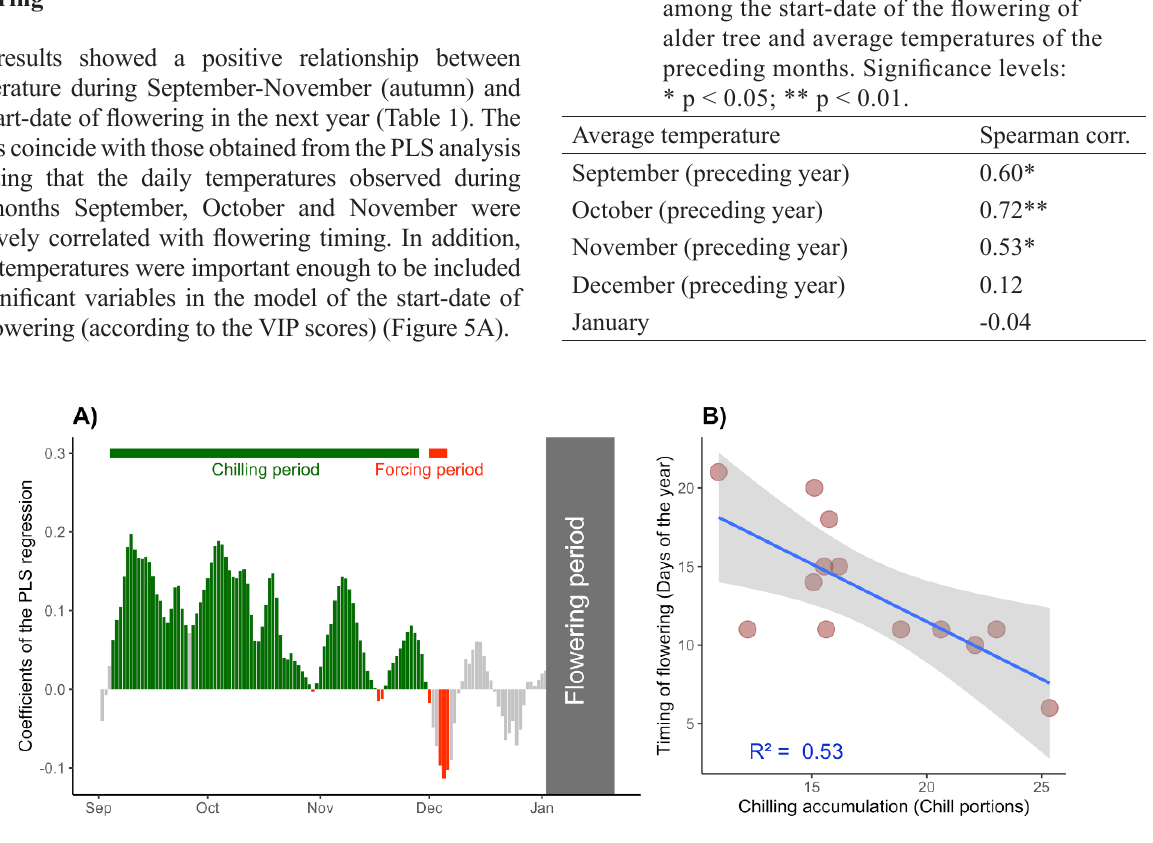
Figure 5. Identification of the chilling (green) and heat (red) accumulation periods following the modeling of the timing of flowering based on the PLS regression using A, daily mean temperatures as predictors, and B, the relationship between the timing of flowering and chilling units calculated during the autumn of the previous year (September-November) using the Dynamic